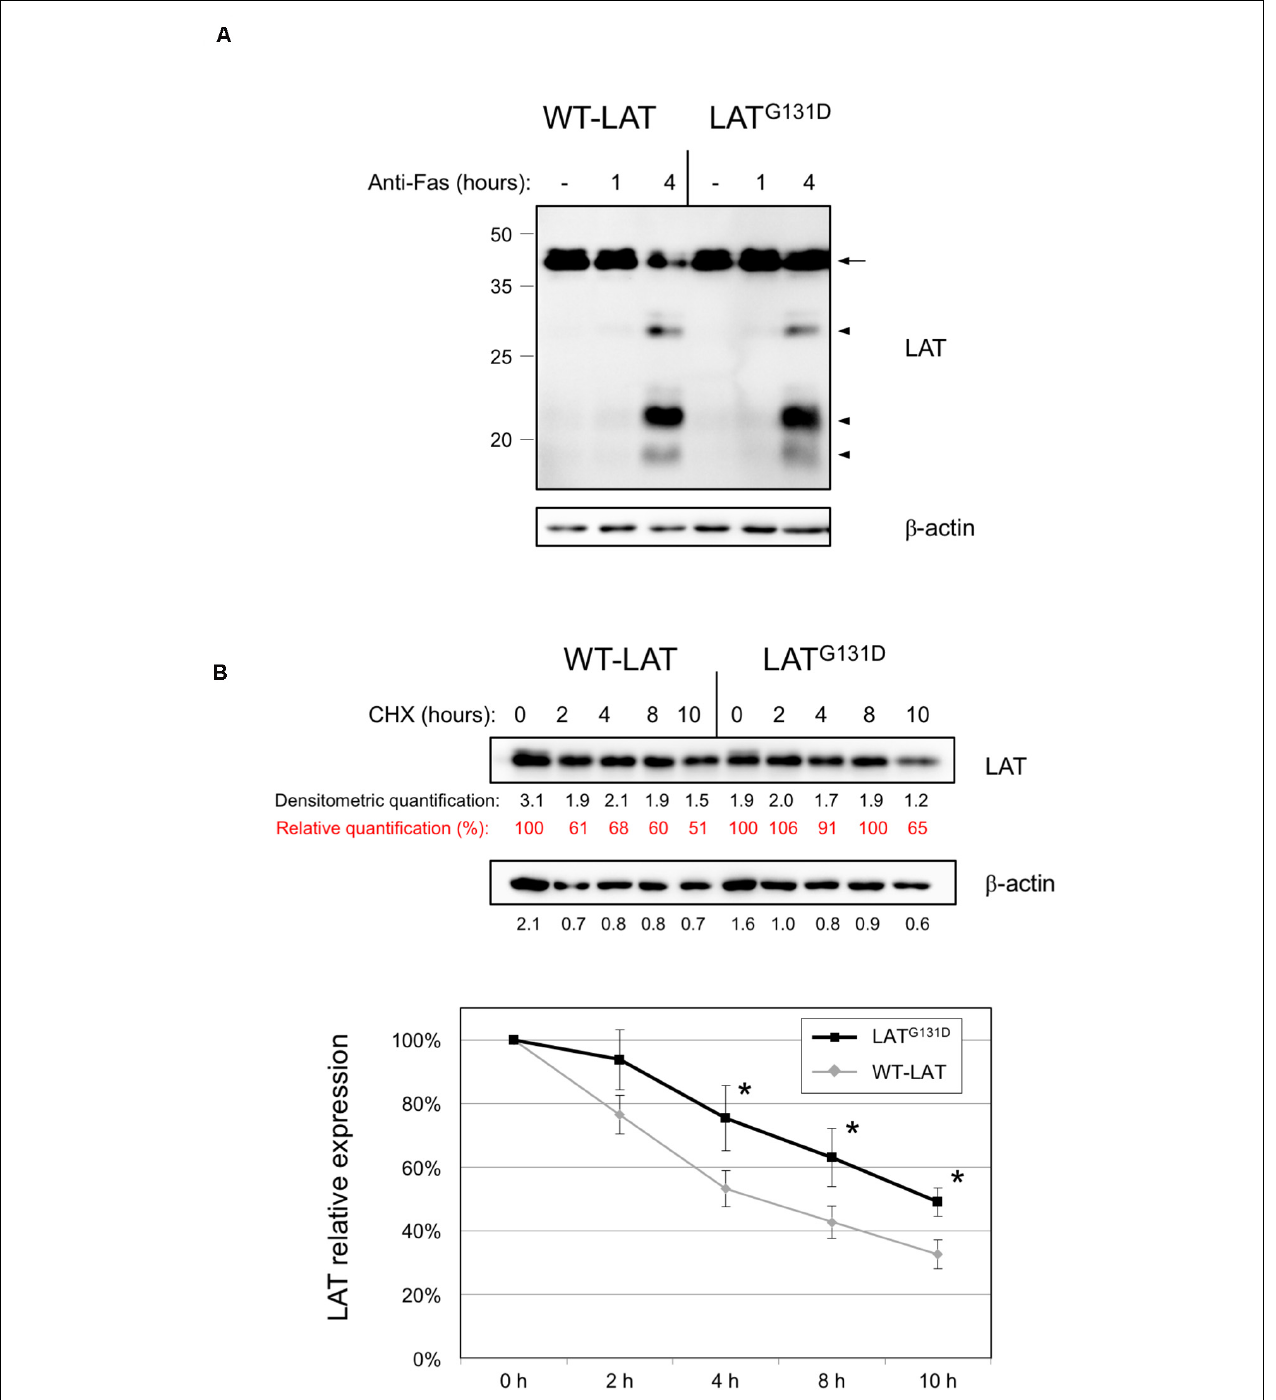
FIGURE 2 | Degradation of WT-LAT and LAT G131D mutant proteins. (A) J.CaM2 cells expressing WT-LAT or the LAT G131D mutant were treated for the indicated time in hours at 37 ◦ C with 100 ng/ml of anti-Fas antibody, and LAT cleavage was assessed in total cell lysates by Western blot with an anti-LAT antibody. Molecular masses in kDa are indicated adjacent to the Western blot. Arrow indicates the band corresponding to the whole LAT molecule, and arrowheads are indicative of the proteolytic fragments. (B) Cell lysates obtained from J.CaM2 cells expressing WT-LAT or the LAT G131D mutant, previously treated with cycloheximide (CHX) for the indicated time in hours, and LAT (upper panel) or β -actin (middle panel) protein levels were analyzed by Western blot. Black numbers below each panel represent the quantification of corresponding bands. Red numbers below LAT panel represent the percentage of LAT expression relative to the one at 0 h of cycloheximide treatment. Densitometric analysis of six experiments was performed, and the relative expression of LAT was represented (lower panel). Bars represent the standard error. Asterisks represent statistical significance.